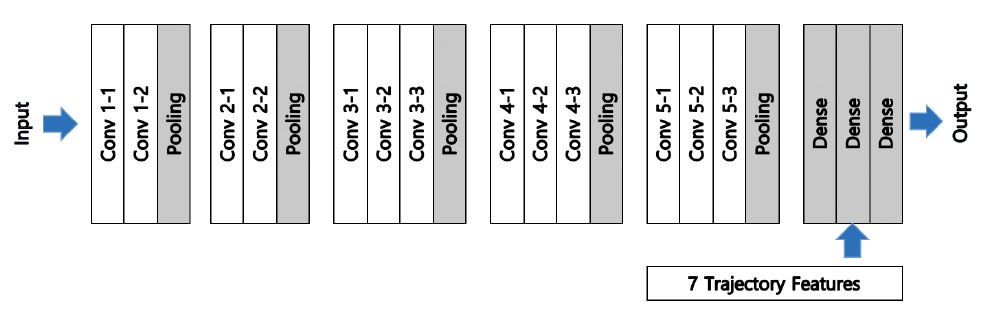
Figure 4. Proposed VGG-16 Network for